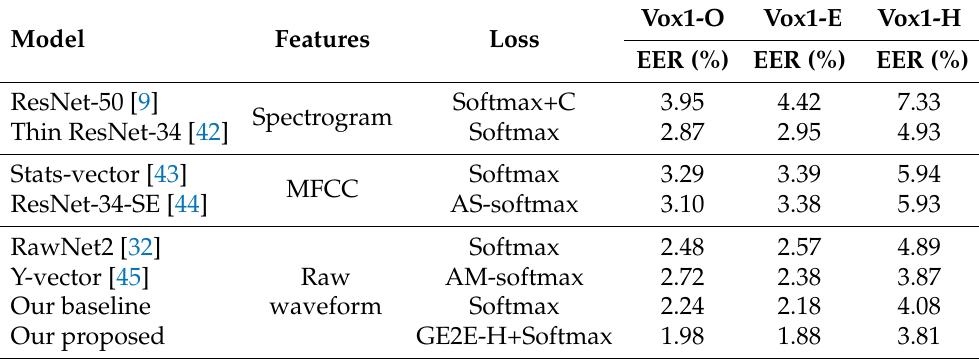
Table 3. Performance comparison results with other speaker verification systems with various models and input features. C: